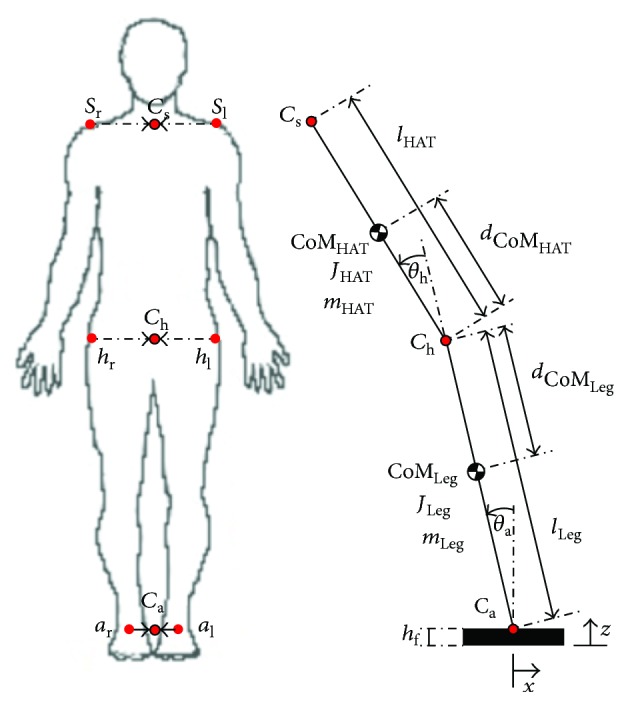
The marker positions (as in the experiment) at ankle, hip, and shoulder and their corresponding centers and the DIP model with: feet (height hf), ankle joint (defined by Ca and angle: Θa), Leg segment between Ca and Ch (defined by: lLeg, COMLeg which is at dCOMHAT from Ch and by mLeg, and inertia JLeg), hip joint (Ch, Θh), and the HAT segment between Ch and Cs (lHAT, COMHAT at dCOMHAT from Ch, and by mHAT, JHAT).